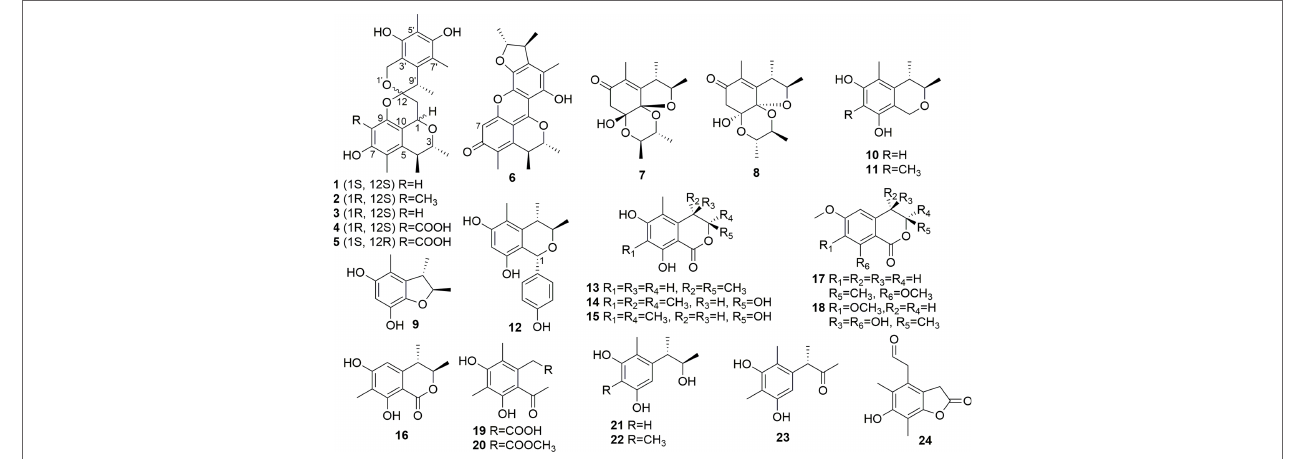
FIGURE 1 | Chemical structures of compounds